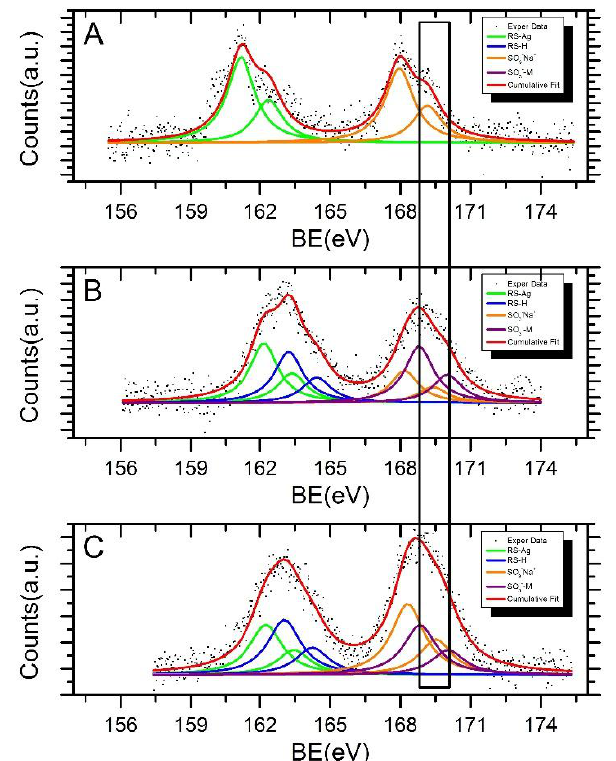
Figure 4. S2p X-ray photoelectron spectroscopy (XPS) spectra of samples AgNPs-3MPS (panel A ); AgNPs-3MPS + Ni 2+ 1 ppm (panel B ); and AgNPs-3MPS + Co 2+ 1 ppm (panel C ).